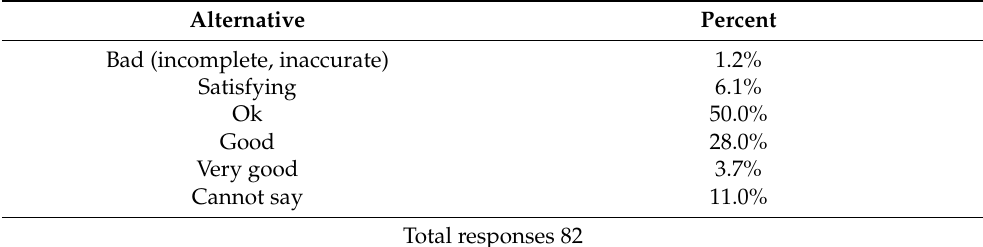
Table A9. The quality of the data according to the